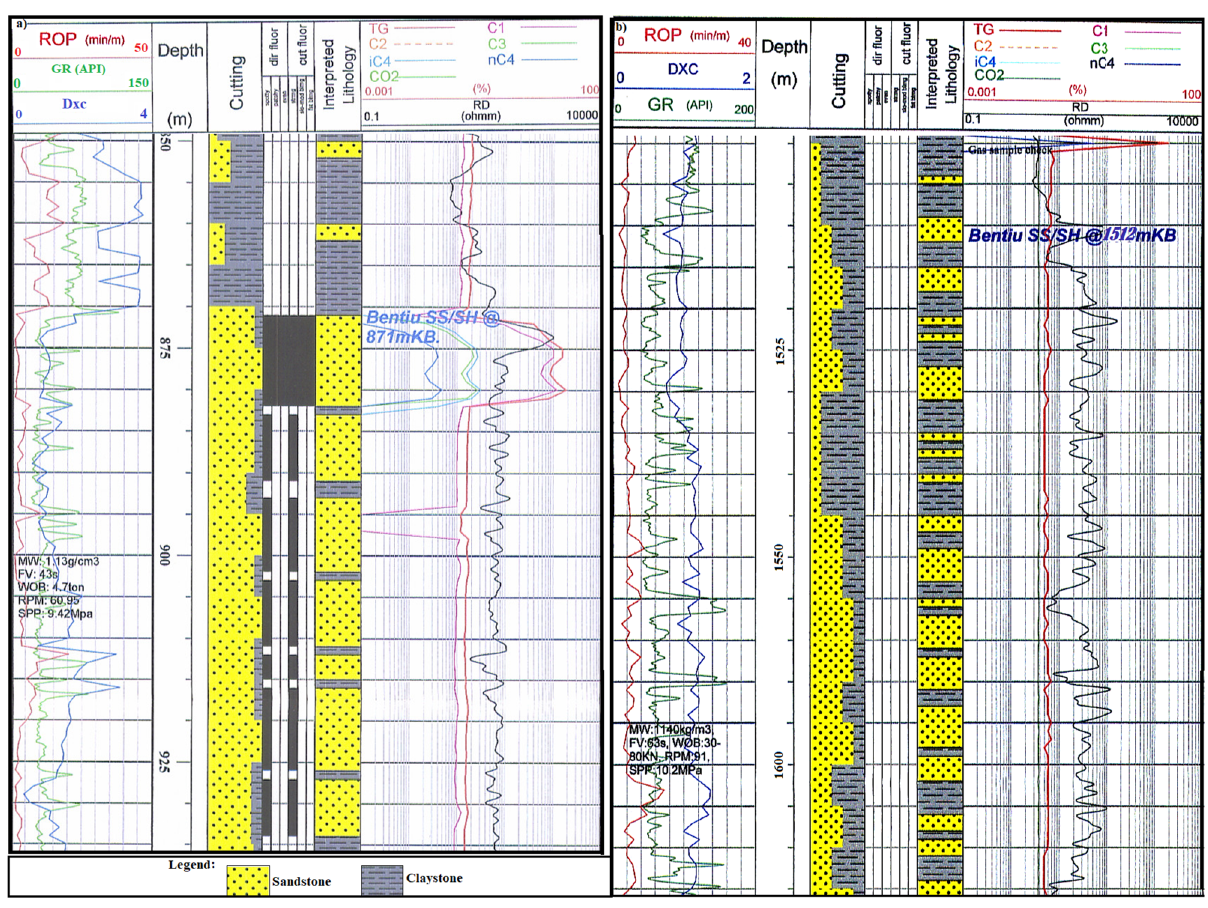
Figure 4. Well log response of the Bentiu Formation in the Great Moga ( a ) and Keyi ( b ) fields showing the results of the wire line logs and lithology (sandstone/claystone) within Bentiu Formation. A suite of measurements includes rate of penetration (ROP), gamma ray (GR) and D-exponent (Dxc). The gamma ray response distinguishes the low gamma ray value of sand from the higher value of shale. The next column (depth track) indicates the depth at which the measurement was